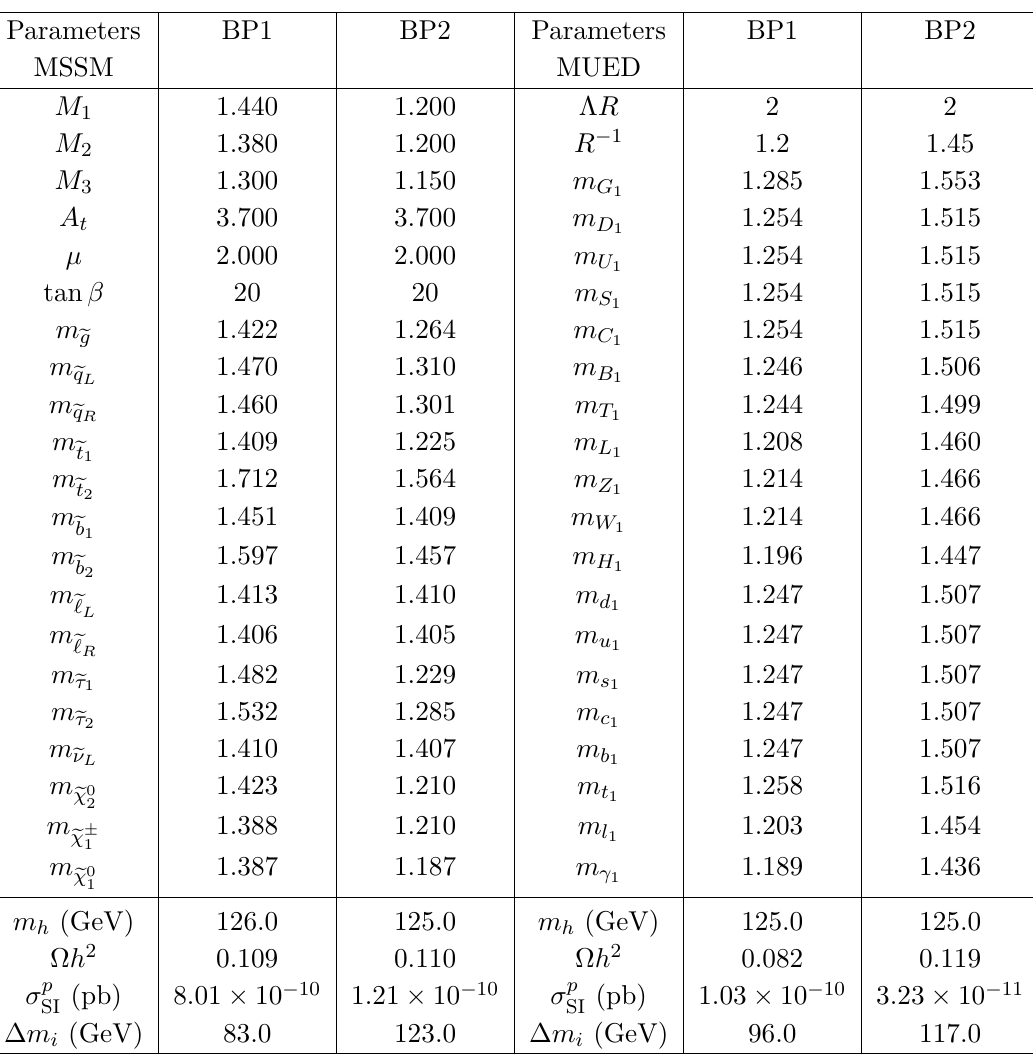
Table 1 . The benchmark points corresponding to compressed spectra in the framework of minimal supersymmetric standard model and minimal universal extra dimension are shown in the left and right side of the table respectively. All the dimensionful input parameters and masses are expressed in units of TeV unless mentioned explicitly. Both the benchmarks are subjected to the constraints from DM relic density and direct detection. Conventional notations are used for MSSM benchmark, whereas, notations for MUED are explained in the text in section